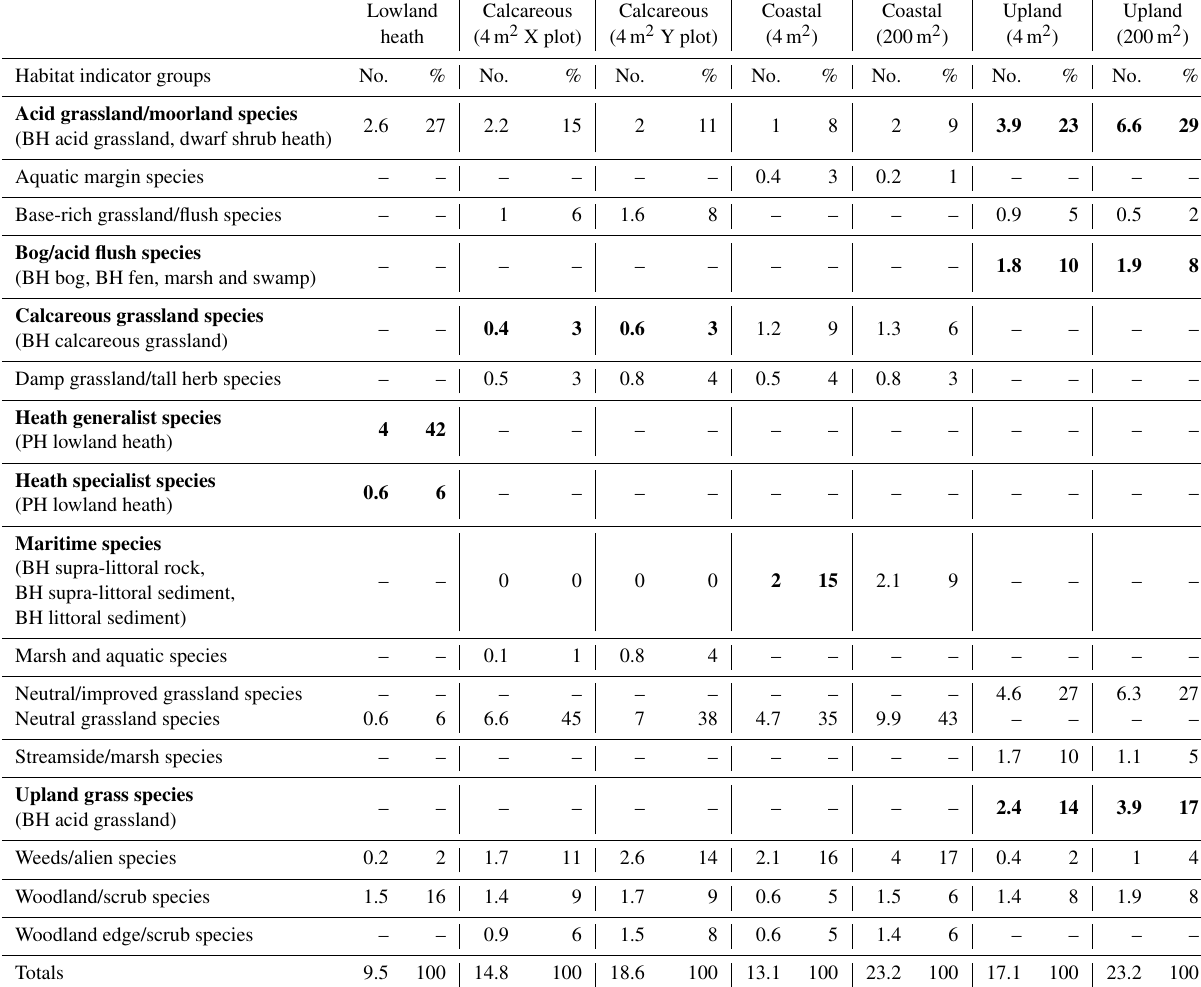
Table 9. Mean number of species in each habitat indicator group per plot in each landscape type in the Key Habitat Survey, with an indication of broad (BH) and priority (PH) habitats where appropriate. Habitat indicator groups characteristic of a landscape type are given in